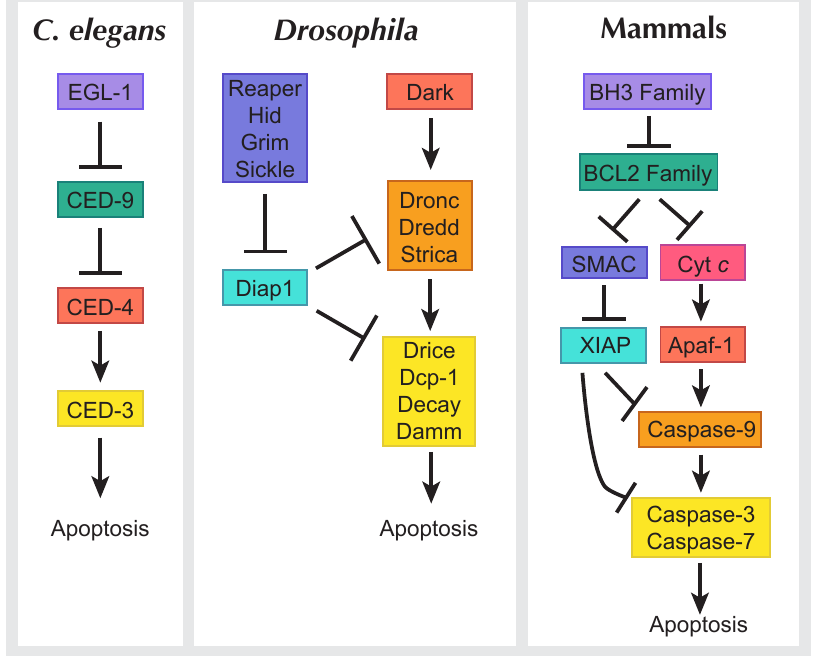
Figure 3. Apoptosis signaling pathways in Caenorhabditis elegans , Drosophila , and mammals. A simplified schematic comparing models of apoptosis across organisms. Similar families across species are shown in matching